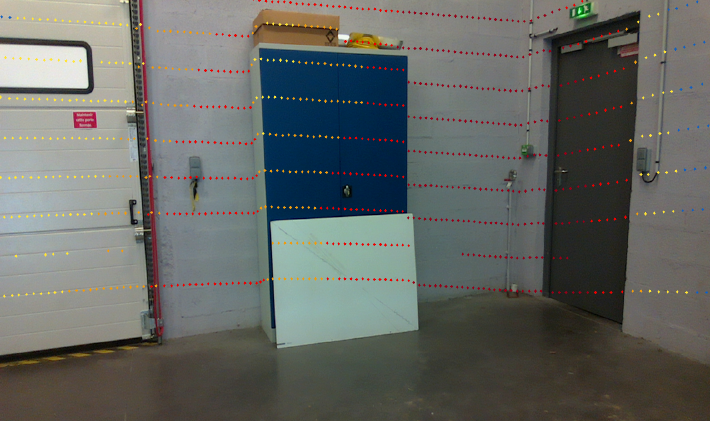
Figure 7. Result of the projection of the LiDAR points on the static image. The coloring is related to the distance (depth) of the point from the sensor.